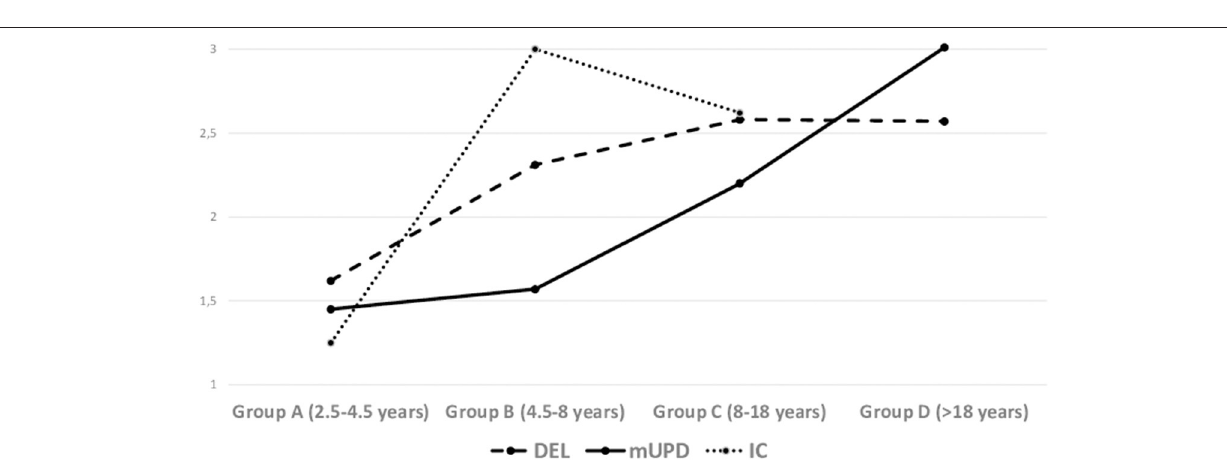
FIGURE 4 | Interaction of age-group by genetic status in hyperphagic behavior. Values on the Y-Axis express the mean values of each